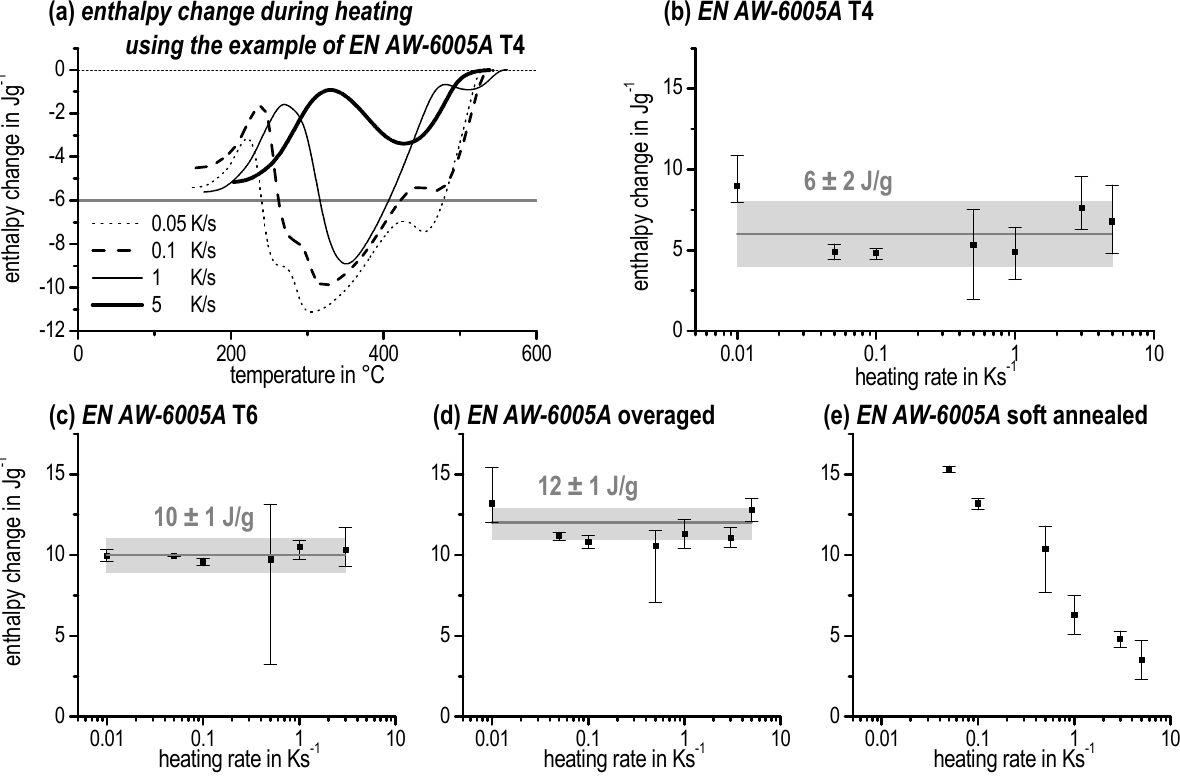
Figure 13. Enthalpy change of EN AW-6005A ( a ) T4, development of enthalpy change during heating with different heating rates. ( b ) T4. ( c ) T6. ( d ) Overaged. ( e ) Soft